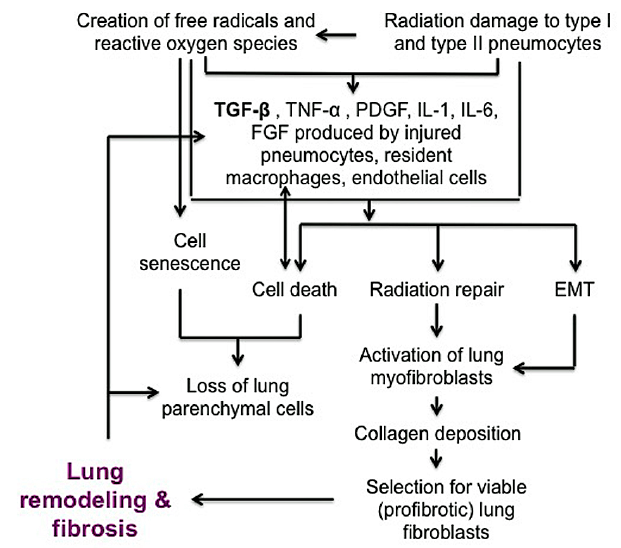
Figure 2. Schematic figure describing the development of radiation-induced chronic lung fibrosis. Radiation causes damage to pneumocytes and induces secondary reactive oxygen species that contribute to a pro-inflammatory environment. Acutely injured lung triggers healing mechanisms that activate (myo)fibroblasts. Excessive accumulation of collagen, which normally inhibits further fibroblast growth, selects for pro-fibrotic, viable lung fibroblasts. Fibroblast activation and selection combined with the inflammatory cytokine cascade, epithelial to mesenchymal transition (EMT), and loss of parenchymal cells leads to ongoing lung fibrosis. The bidirectional arrow indicates that cell death creates inflammatory cytokine production which further increases cell death.